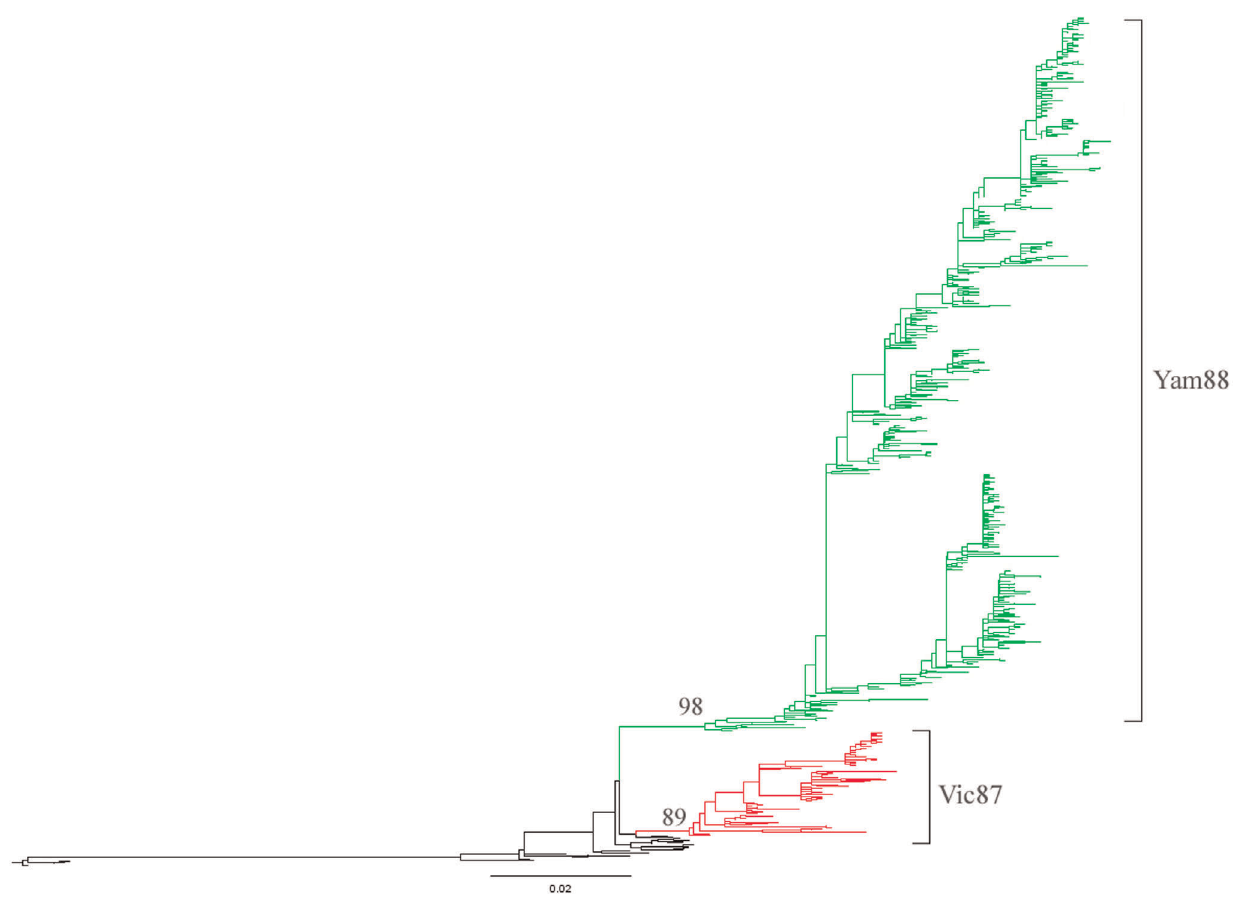
Figure 3. Maximum-likelihood (ML) tree of influenza B NA genes. Two lineages, Yam88 and Vic87, were classified. The bootstrap values supporting the corresponding lineages are shown on the major nodes. The scale bars indicate the numbers of nucleotide substitutions per site. ( d S ) substitutions per site ( d N /d S ) (Table 3). Within influenza A, the highest d N /d S ratio was observed in 2B - human N2 lineage (0.313),